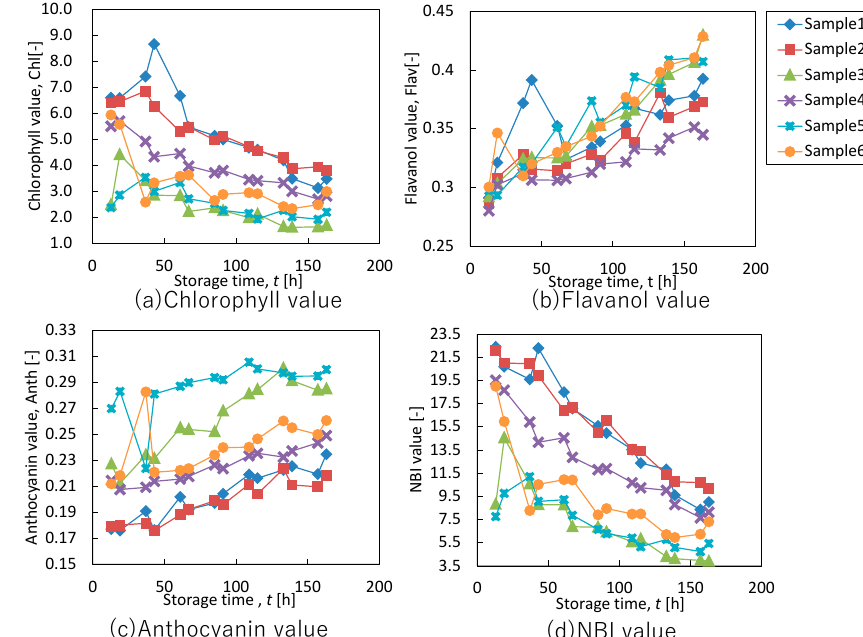
Fig. 15: Pigment (Chl, Flav, Anth, NBI) change